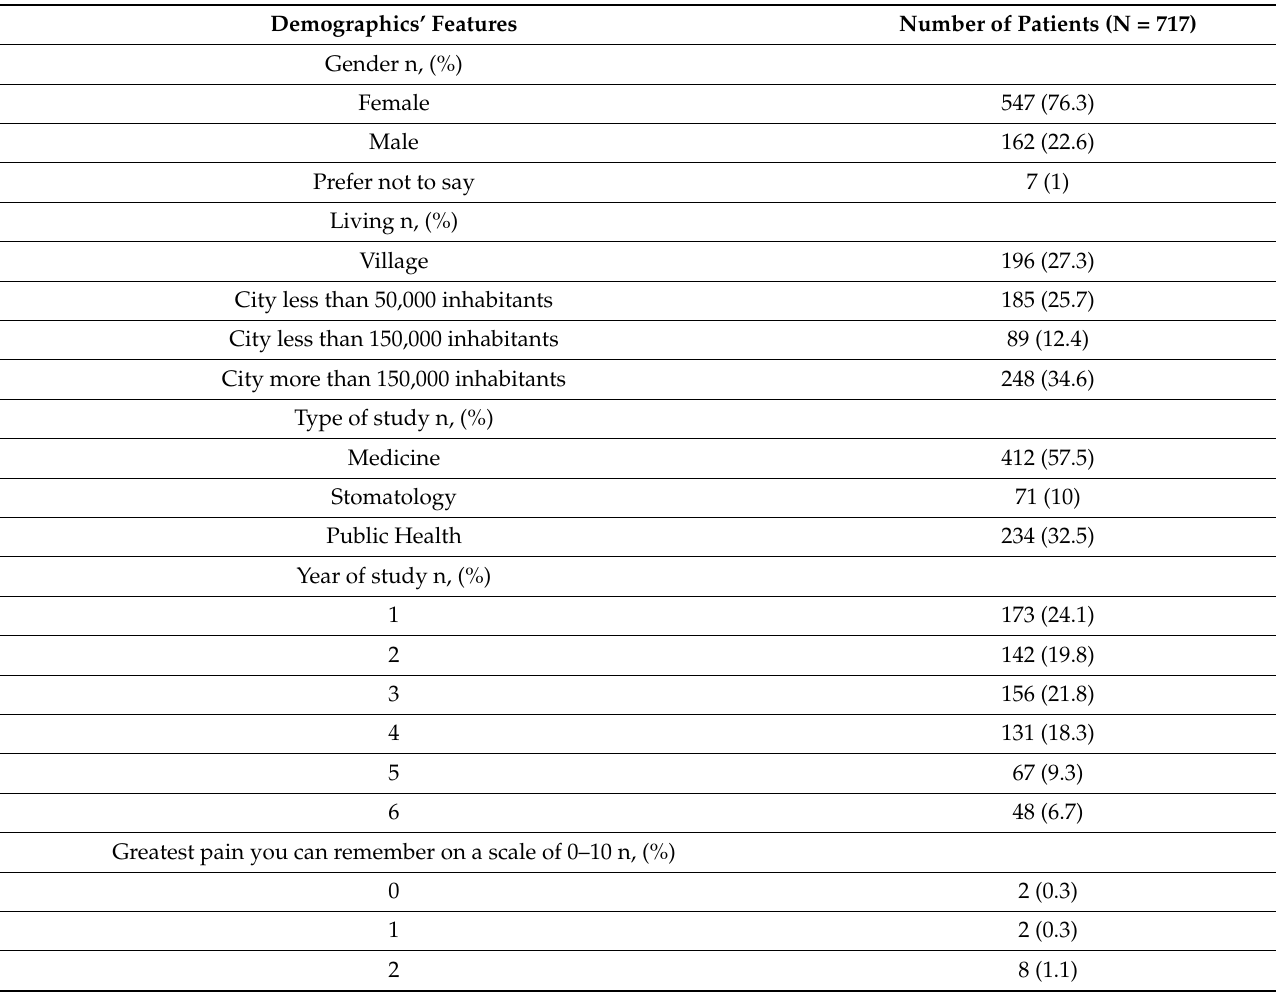
Table 1. Patient baseline